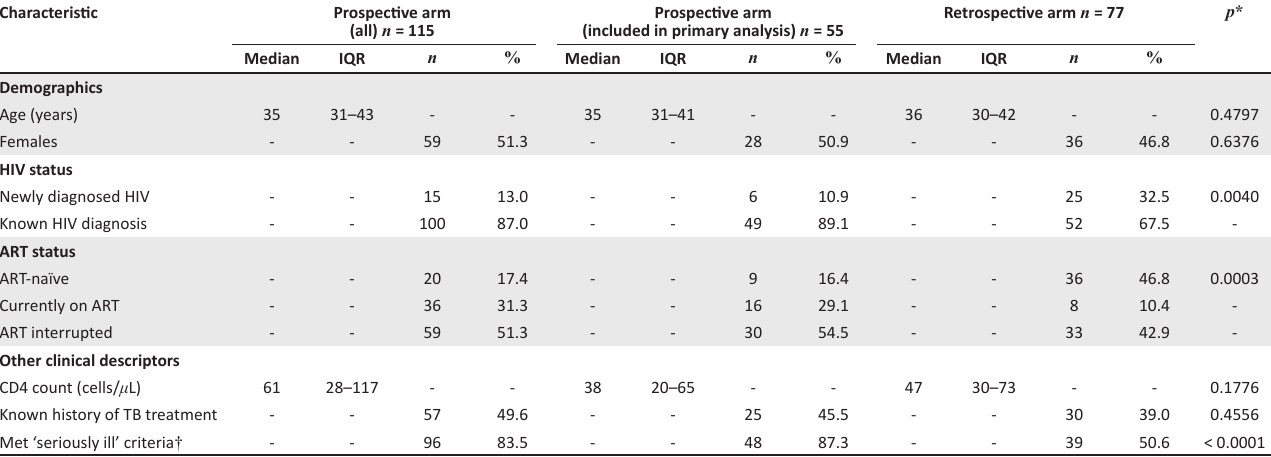
TABLE 1: Baseline characteristics of the study population. Characteristic Prospective arm